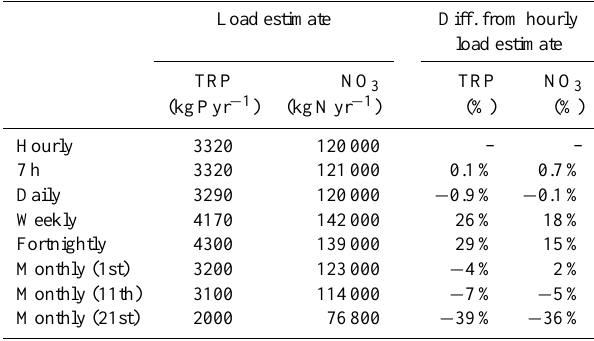
Table 1. Annual load estimation, to three significant figures, based on data of differing resolutions from the River